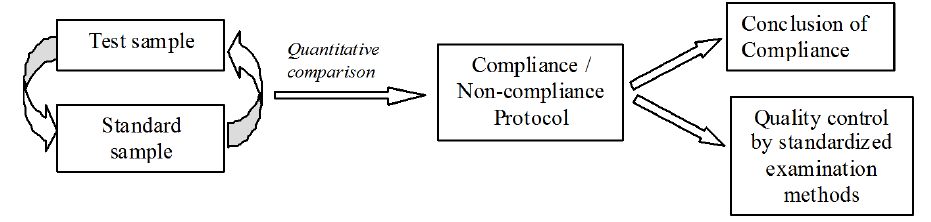
Figure 8. Scheme of incorporating the proposed method into the procedure of assessing the compliance of a liquid with its standard.